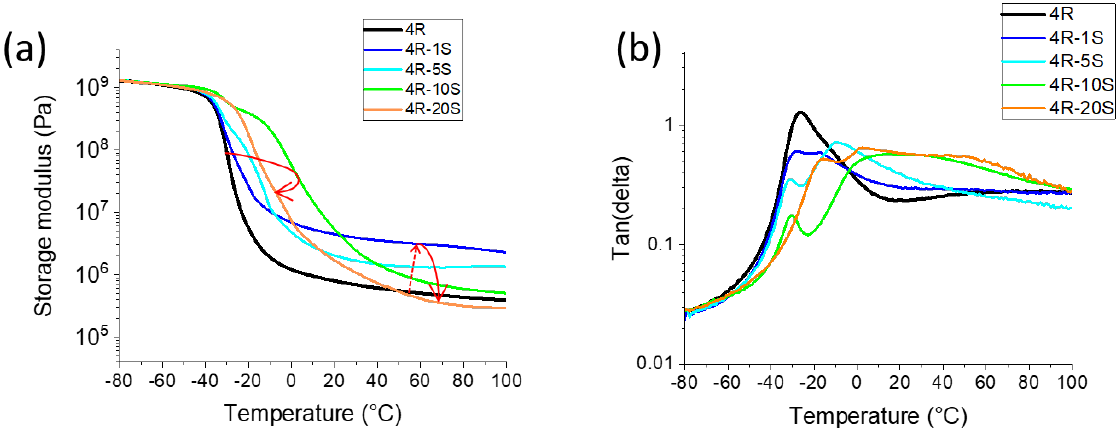
Figure 6. Effect of SMA co-monomer content on thermo-mechanical properties: DMTA analysis of neat polyMEA, as well as of nanocomposites containing 4 wt.% of RDS clay and additionally 1, 5,